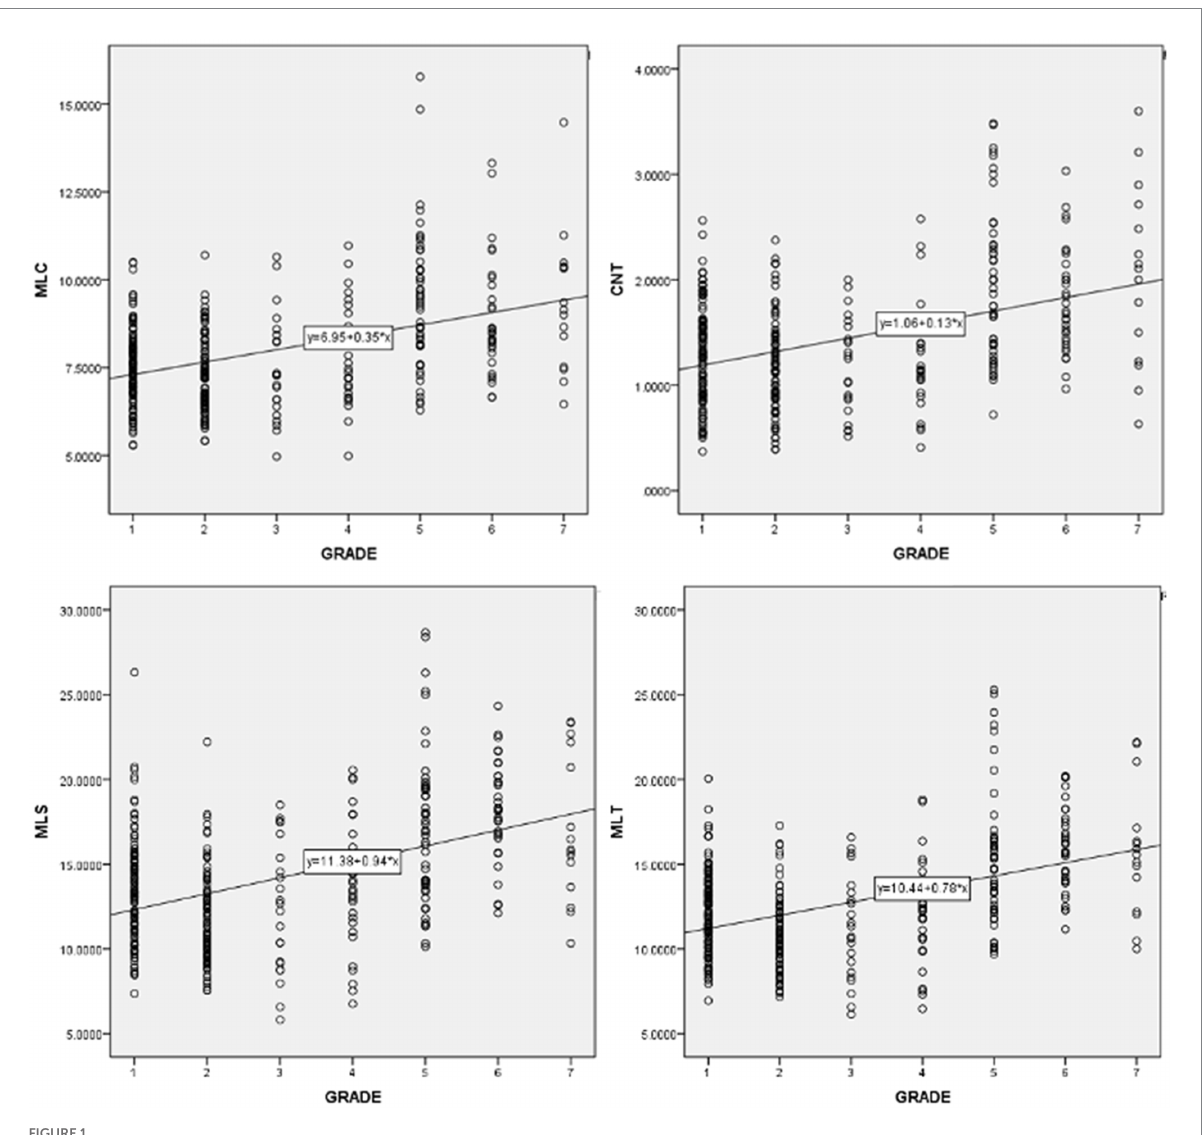
FIGURE 1 Scatter diagrams of indices which moderately correlate with